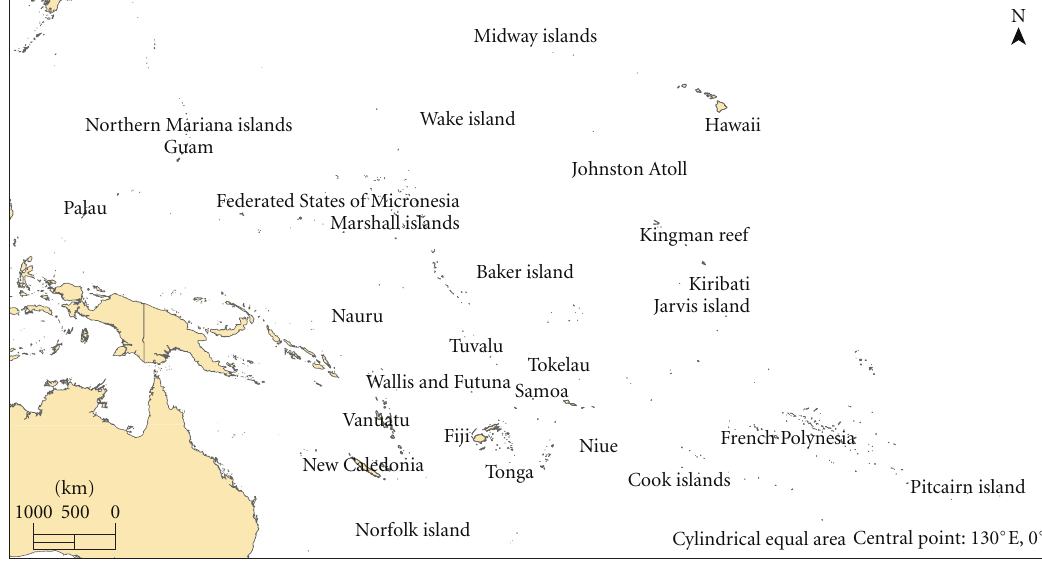
Figure 1: Major islands and regions of